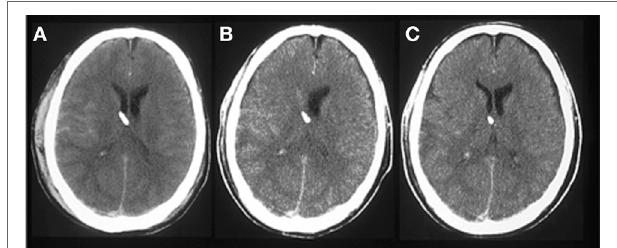
FiGURe 9 | A CT scan of the brain from a 45-year-old man after a severe traumatic brain injury. (A) A CT scan before the start of drainage at an intracranial pressure of 32 mmHg. (B) A CT scan after 1 day of ventricular drainage, at a drainage level of 22 mmHg. (C) CT scan 2 days after drainage was stopped. Ventricular size was reduced by the drainage, and partly restored after the drainage was stopped. The figure supports the presented principles for transvascular fluid exchange in the injured brain with disrupted blood–brain